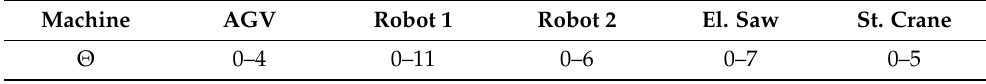
Table 1. Machines and respective number of discrete operation states Θ .